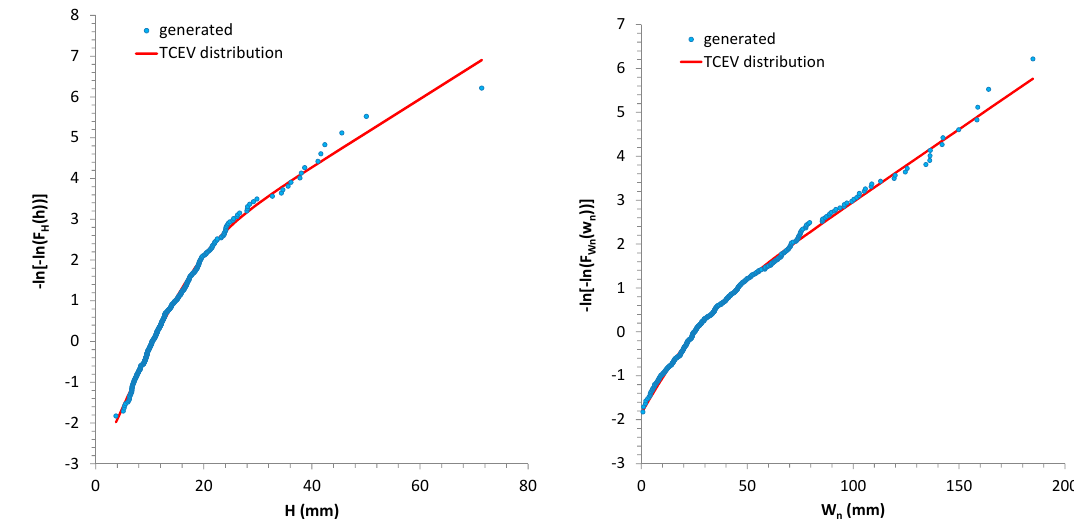
Figure 4. EV1 probabilistic plot: comparison between empirical Cumulative Density Function (CDF) and Two Component Extreme Value (TCEV) distribution for both H ( left ) and W n ( right ).